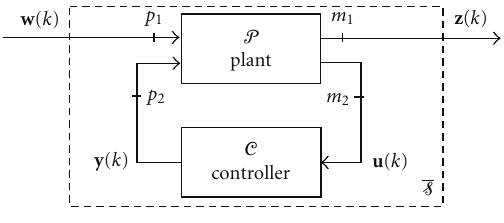
Figure 5: Closed-loop system